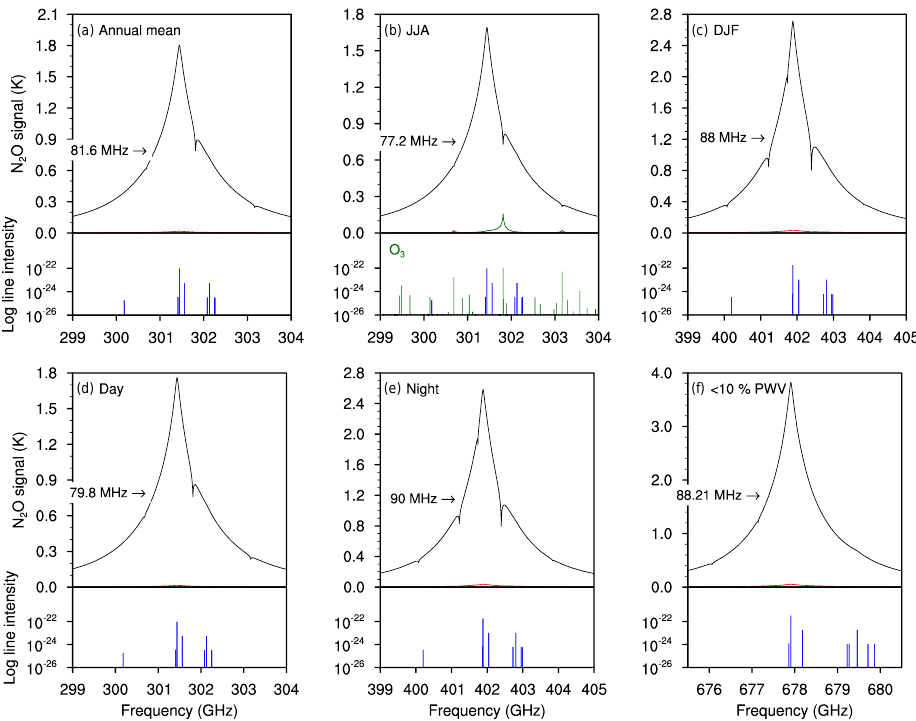
Figure 13. Same as Fig. 10 but for N 2 O. Units of the ordinate scale are